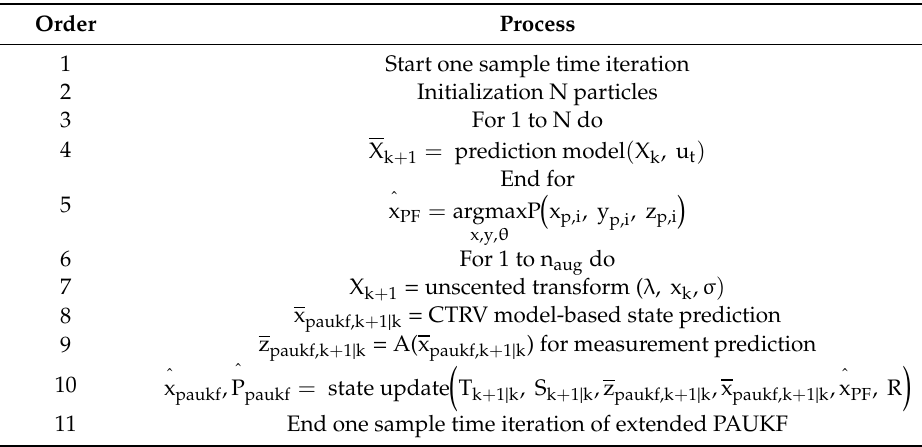
Table 1. The pseudocode of extended